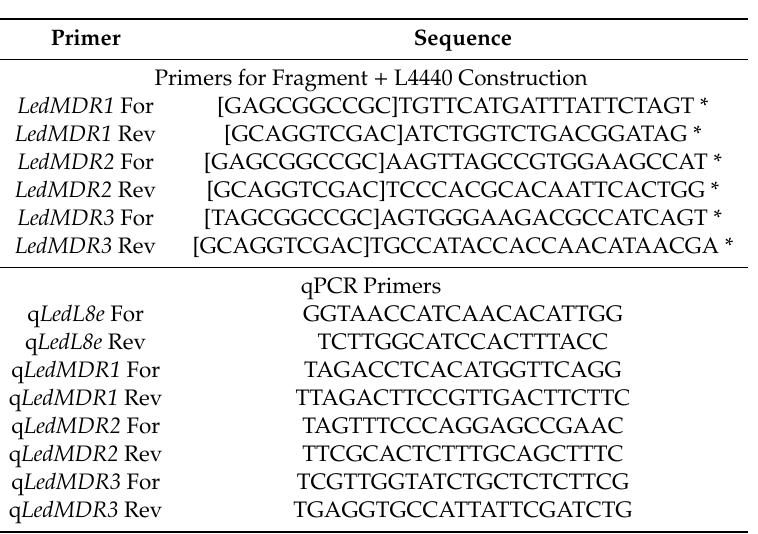
Table 1. Primers used for double-stranded RNA (dsRNA) fragment synthesis and qPCR expression measurement of L. decemlineata ABCB (LedMDR) genes in di ff erent tissues of the Colorado potato